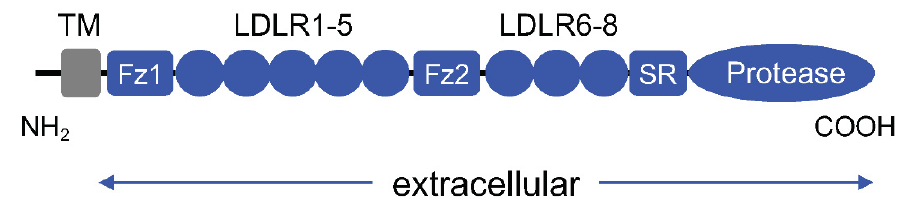
Figure 1. Schematic presentation of corin protein domains. Corin consists of an N-terminal (NH 2 ) cytoplasmic tail, a single-span transmembrane domain (TM), and an extracellular region (indicated) that includes two frizzled domains (Fz1 and Fz2), eight low-density lipoprotein receptor-like repeats (LDLR1-8), a scavenger receptor-like domain (SR), and a trypsin-like serine protease domain at the C-terminus (COOH).